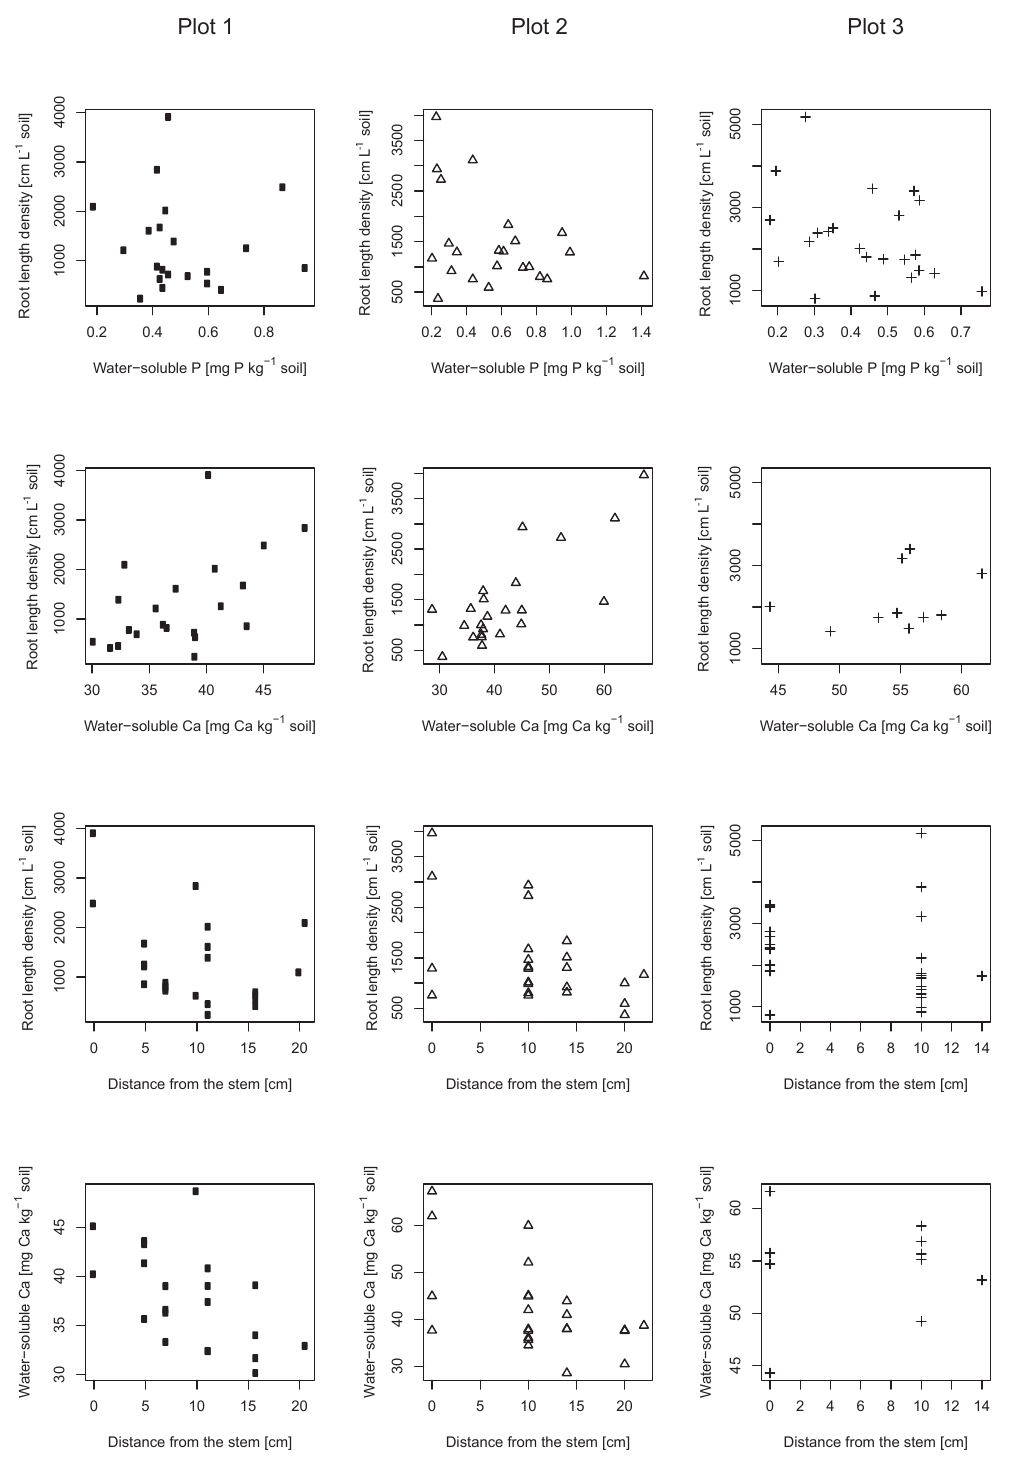
Fig. 4. The relationship between root length and water-soluble P (first row) or water-soluble Ca (second row) as well as the relationship between the distance from the stem and root length density (third row) or water-soluble Ca (fourth row) investigated in the high-density sampling on the experimental site (ES) in the topsoil (0–10cm) of the plots with low (plot 1), intermediate (plot 2) and high vegetation density (plot